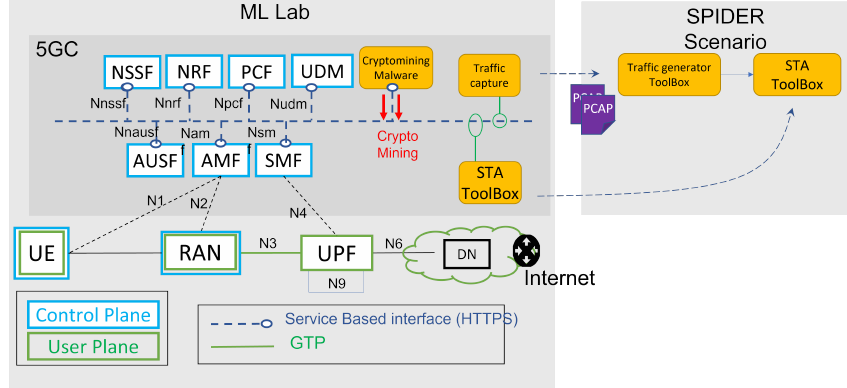
Figure 9. Cryptomining discovery scenario.